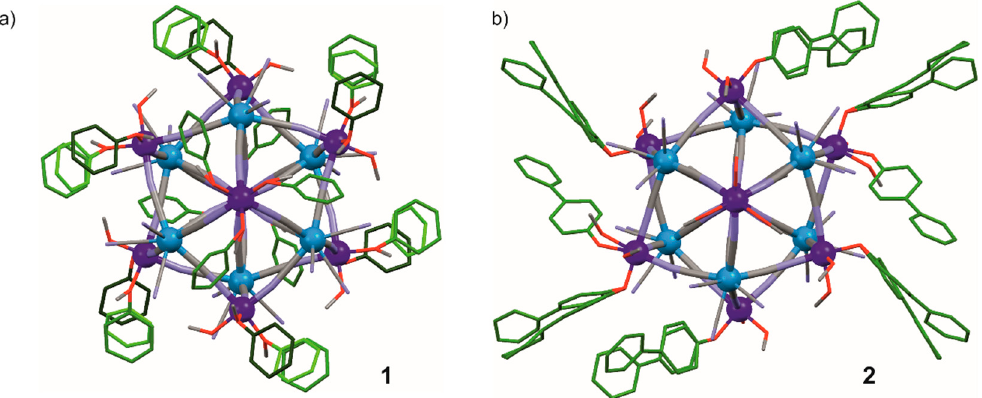
Figure 1. Pentadecanuclear clusters in the crystal structure of 1 ( a ) and 2 ( b ). Hydrogens atom, crystallization solvents, and non-coordinated ligands were omitted for clarity. Legend: Co—navy blue; W—light blue; C—dark gray; N—violet; O—red; C and N in pyNO and 4-phpyNO ligands-dark green (75% occupancy), green (50% occupancy), and light green (25% occupancy) (for details see Supplementary Materials).